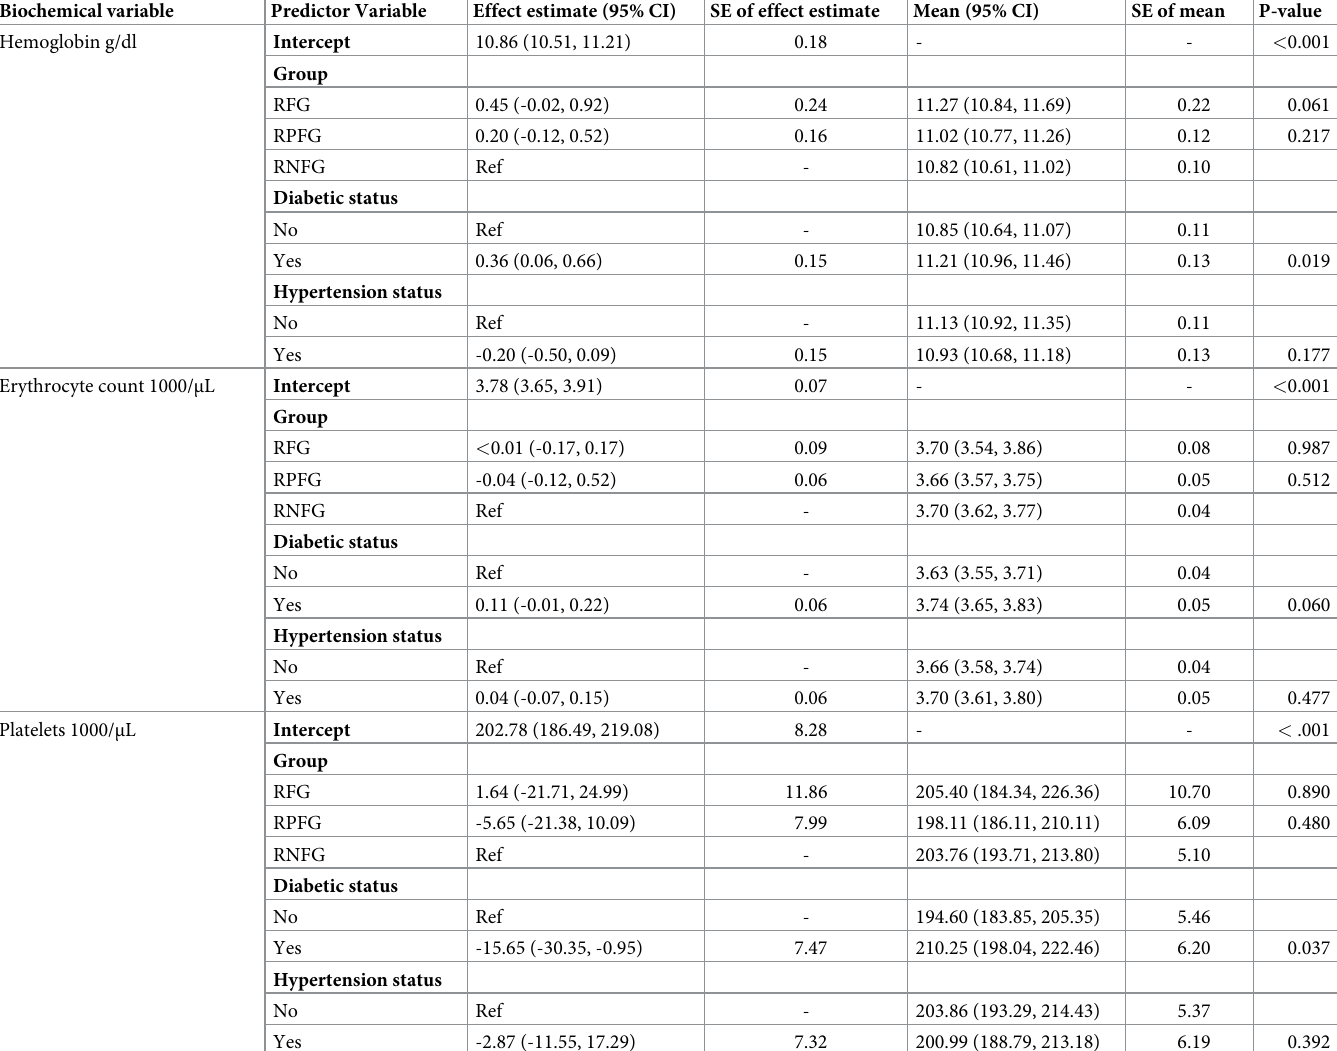
non- diabetic patients (95% CI 0.25, 0.72; p < 0.001). Diabetic patients had slightly higher mean albumin by 0.12 g/dl than non-diabetic patients (95% CI 0.04, 0.20; p 0.004). Mean serum creatinine was lower in diabetic patients than non-diabetic patients by 0.52 md/dl (95% CI -0.97, -0.07; p 0.023). Additionally, mean sodium was slightly higher in diabetic patients than non- diabetic patients by 2.29 mEq/l (95% CI -3.08, -1.51; p < 0.001). In addi- tion, mean hemoglobin was slightly higher in patients with diabetes than non-diabetic patients by 0.36 g/dl (95% CI 0.06, 0.66; p 0.019). Also, slight decrease in mean platelets by 15.65 1000/ μ L among diabetic patients as compared to those without diabetes (95%